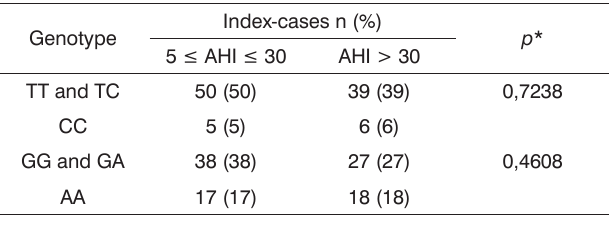
Table 7. Distribution of the AHI (apnea/hypopnea index) of index cases relative to the genotypes for T102C and -1438G/A polymorphisms of the 5-HTR2A